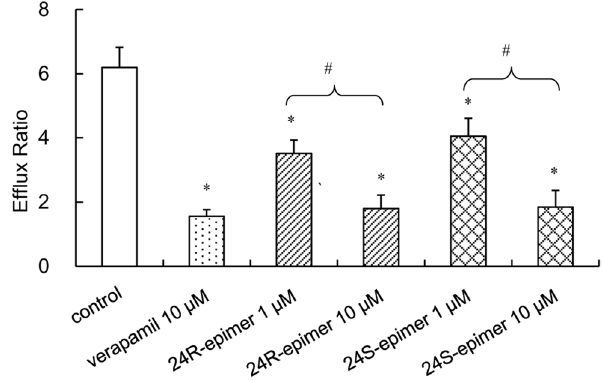
Figure 6. Effects of 24R-epimer and 24S-epimer on the transport of P-gp substrate digoxin across Caco-2 cell mono- layers. Cells were preincubated for 1 h with 24R-epimer (1 and 10 m M) or 24S-epimer (1 and 10 m M), and followed by co-incubation for 2 h in the presence of 5 m M digoxin. Data are the mean 6 S.E. of three independent experiments. * p , 0.01 versus control, # p , 0.01 between groups.